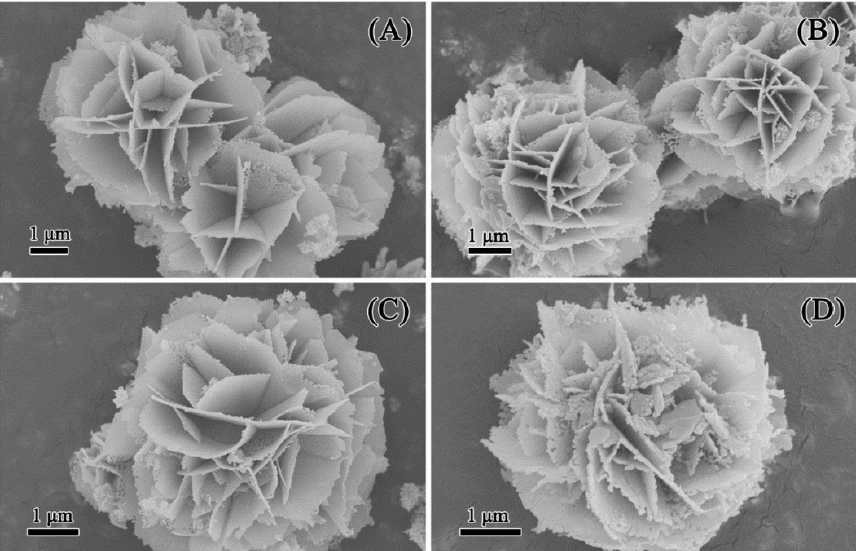
Figure 7. SEM images of Fe-containing ceria materials produced from solutions containing urea and citric acid. Fe%: ( A ) = 0, ( B ) = 4, ( C ) = 8, ( D ) = 12 [73]. Reprinted with permission from Zheng, X.; Li, Y.; Zheng, Y.; Shen, L.; Xiao, Y.; Cao, Y.; Zhang, Y.; Au, C.; Jiang, L. Highly Efficient Porous Fe x Ce 1-x O 2- δ with Three-Dimensional Hierarchical Nanoflower Morphology for H 2 S-Selective Oxidation.